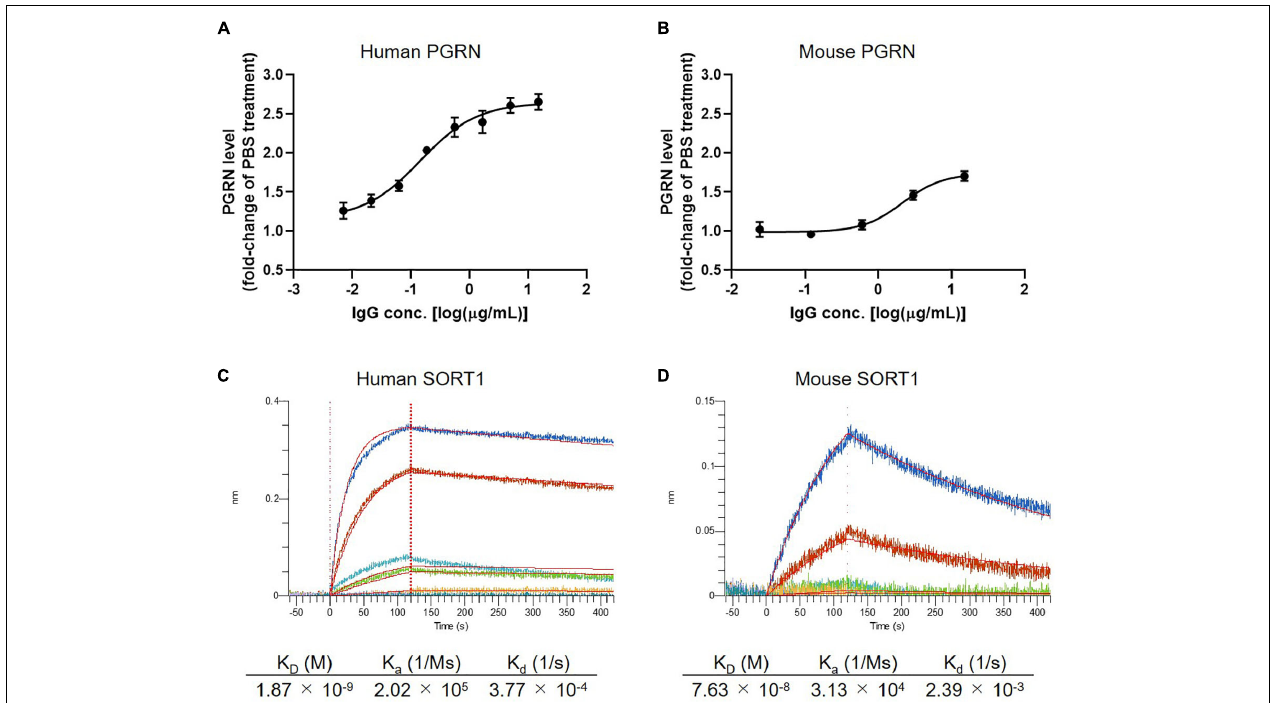
FIGURE 2 | Detailed characterization of anti-SORT1 mAb K1-67. (A) PGRN up-regulation in response to K1-67 in U251 human glioblastoma cells. Cells were treated with various concentrations of K1-67 for 72 h. Human PGRN in U251 culture supernatant was determined by ELISA and is shown as a fold-change relative to PBS-treated cells. Data are mean ± SEM from 3 independent experiments. (B) PGRN up-regulation in response to K1-67 in mouse primary neurons. Cells were treated with various concentrations of K1-67 for 7 days. Mouse PGRN in mouse primary neuron culture supernatant was determined by ELISA and is shown as a fold-change relative to PBS-treated cells. Data are mean ± SEM from 3 independent experiments. (C,D) Affinity of K1-67 to SORT1. BLI was used to determine the affinity of K1-67 toward human and mouse SORT1 with K1-67 as a ligand and with SORT1-His protein as an analyte. The vertical axis indicates the BLI signal response (nm), and the horizontal line indicates the time after analyte loading. Kinetic parameters were analyzed using a 1:1 Langmuir fitting model. Association ( K a ) and dissociation ( K d ) constants were calculated and used to determine the K D value ( K d / K a